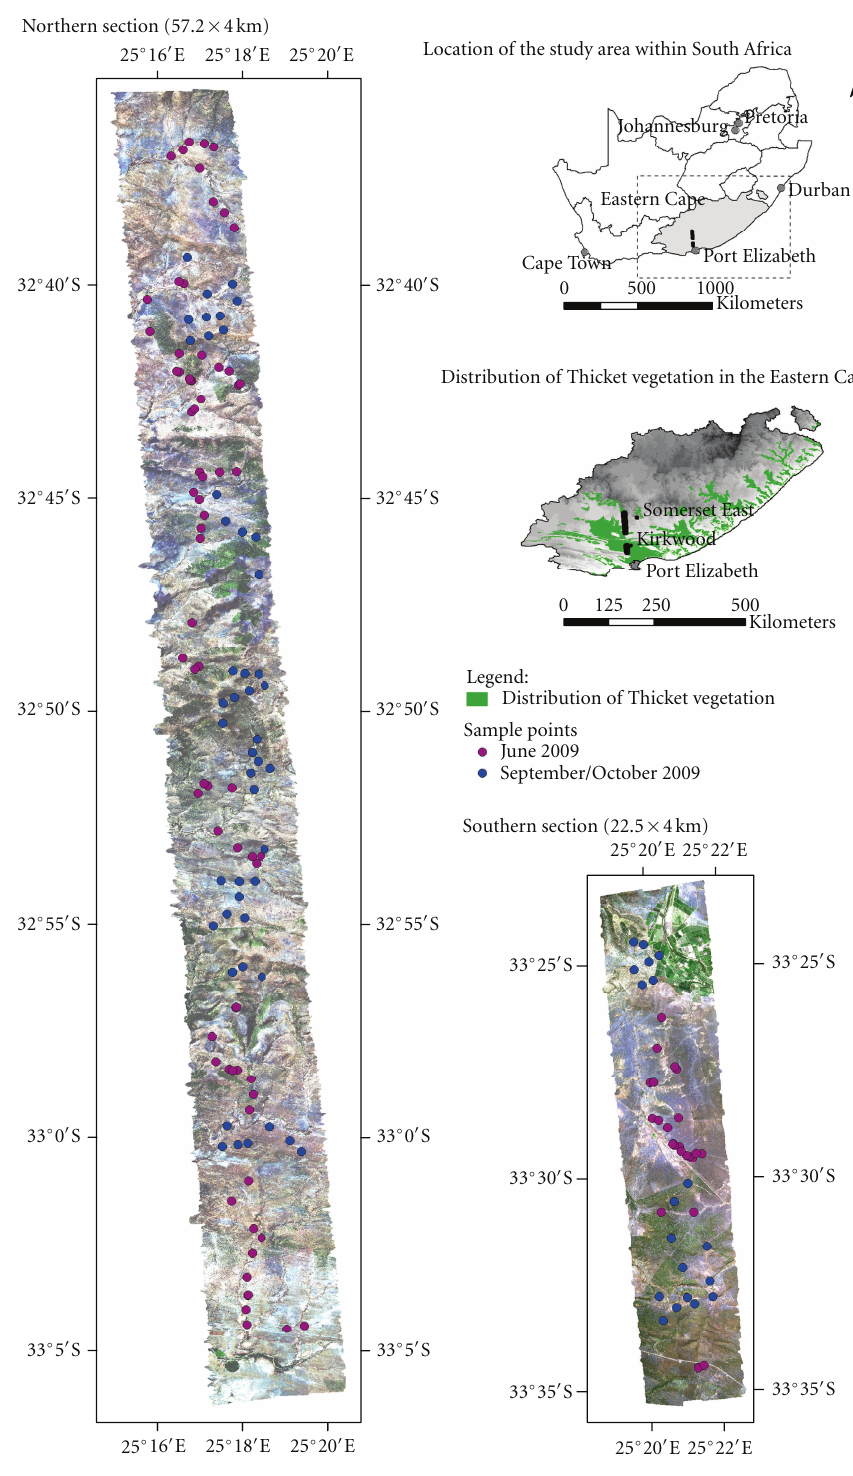
Figure 2: Detailed view of the HyMap imagery of the two transects west of Somerset East and in the Kirkwood vicinity in the Eastern Cape Province, South Africa, showing the distribution of the sampled sites. Each transect section comprises three HyMap flight